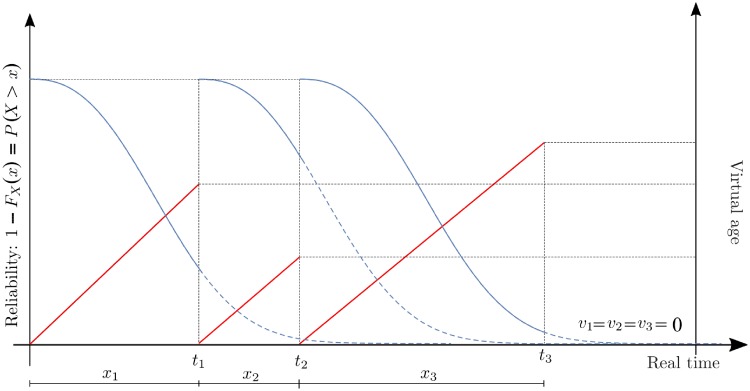
Failure time distribution and effective age.Complementary CDF of the failure time (blue) and effective age (red) for q = 0. At the time of recessions, we observe how interventions modify the effective age resulting in a new virtual age vi.